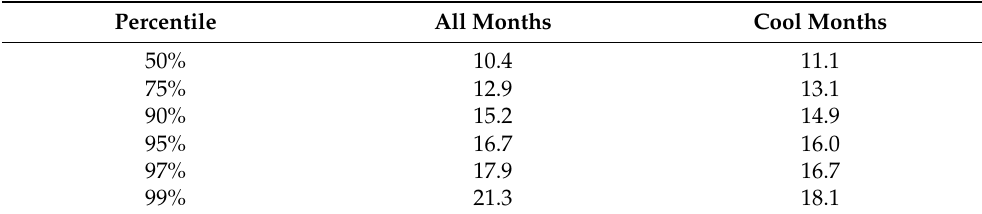
Table 2. Key percentiles in climatological distribution of daily maximum 10-min sustained wind speed (m/s) over Waglan Island in